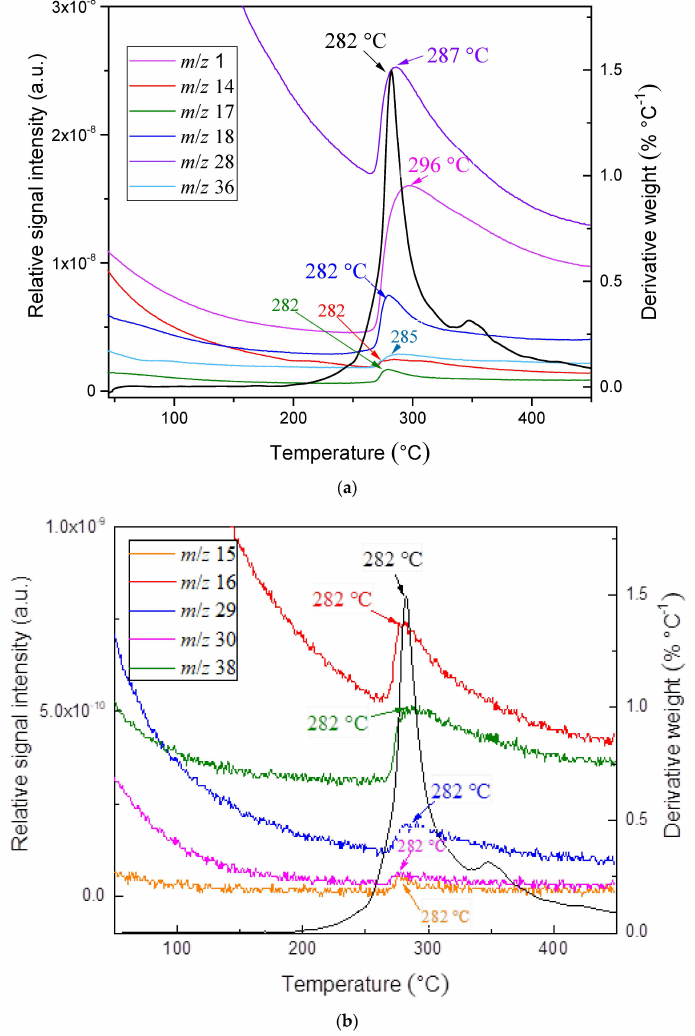
Figure 3. ( a , b ) The DTG curves and TG-MS fragment ion intensities for AMB